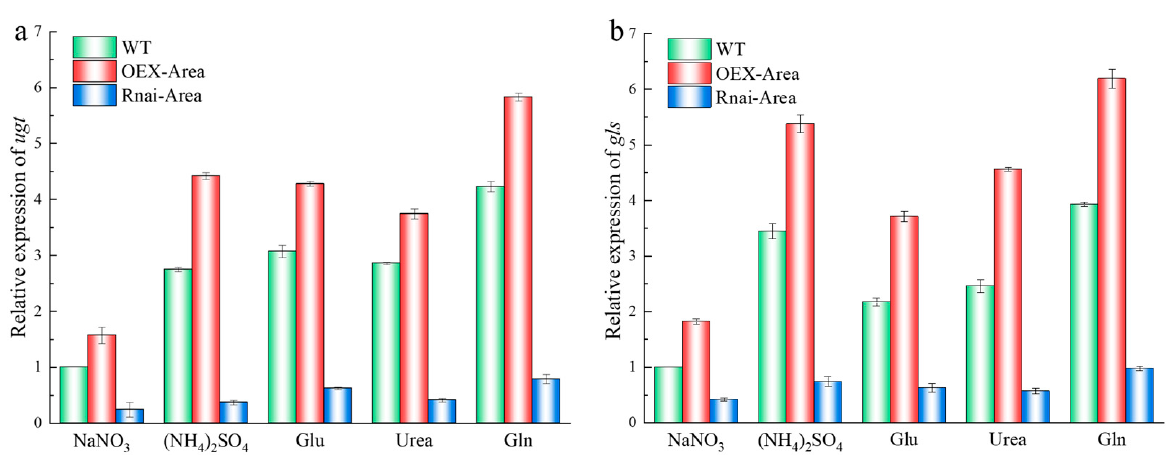
Figure 7. Changes of expression quantity Area of mutant strains under different nitrogen sources; ( a ) UDPG. ( b ) GLS